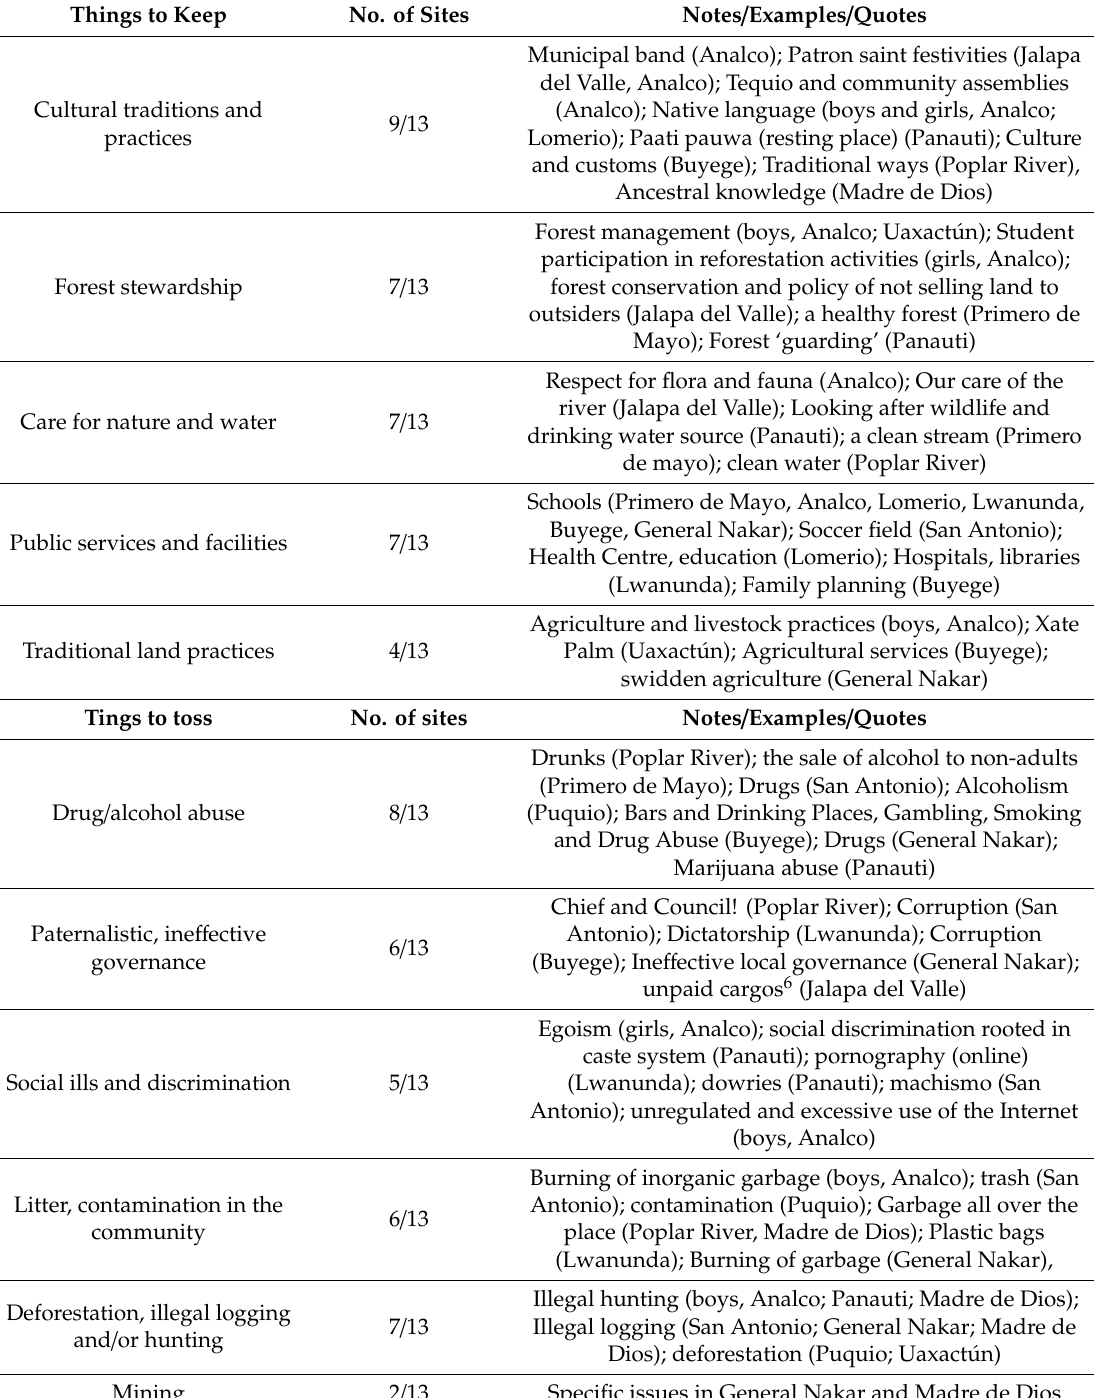
Table 3. What youth want to “Keep" and to "Toss" from their communities. Things to